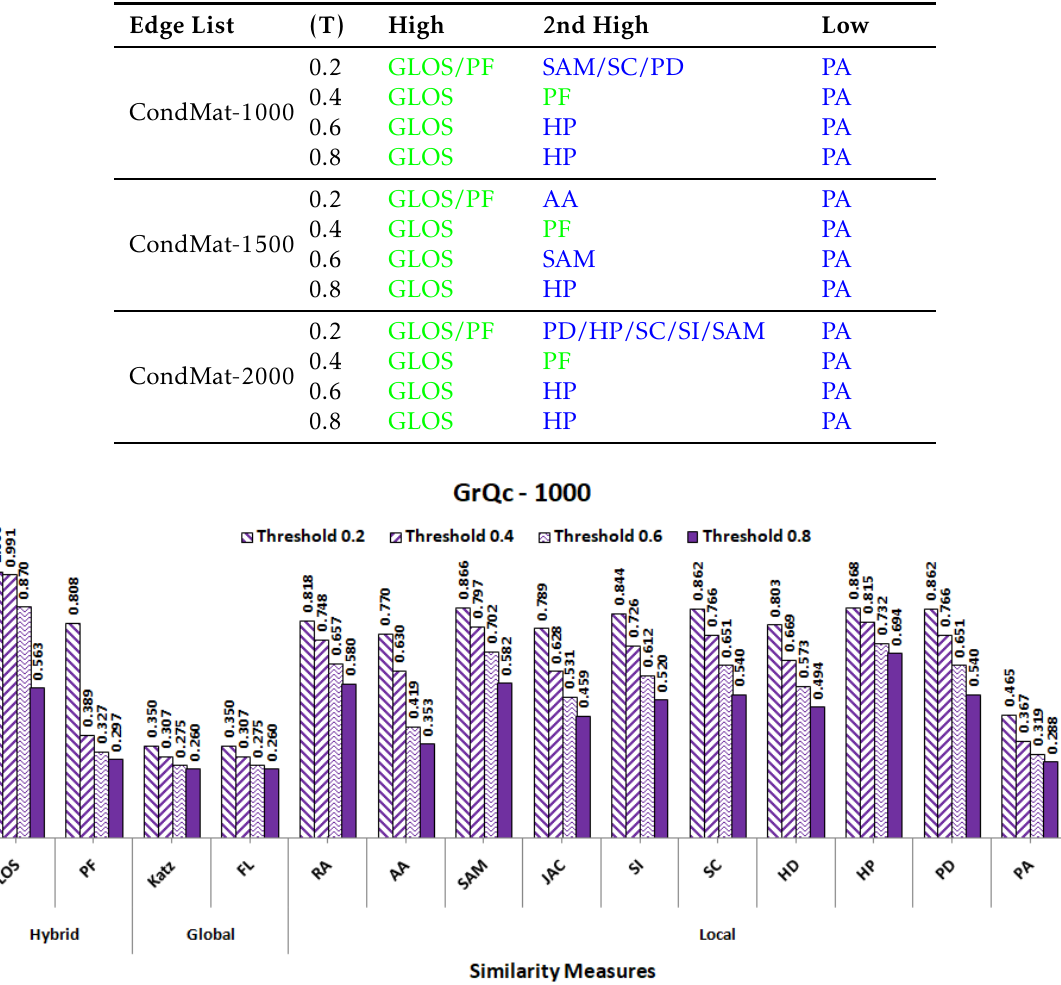
Figure 13. Comparisons of similarity measures on GrQc-1000 edge list from GrQc